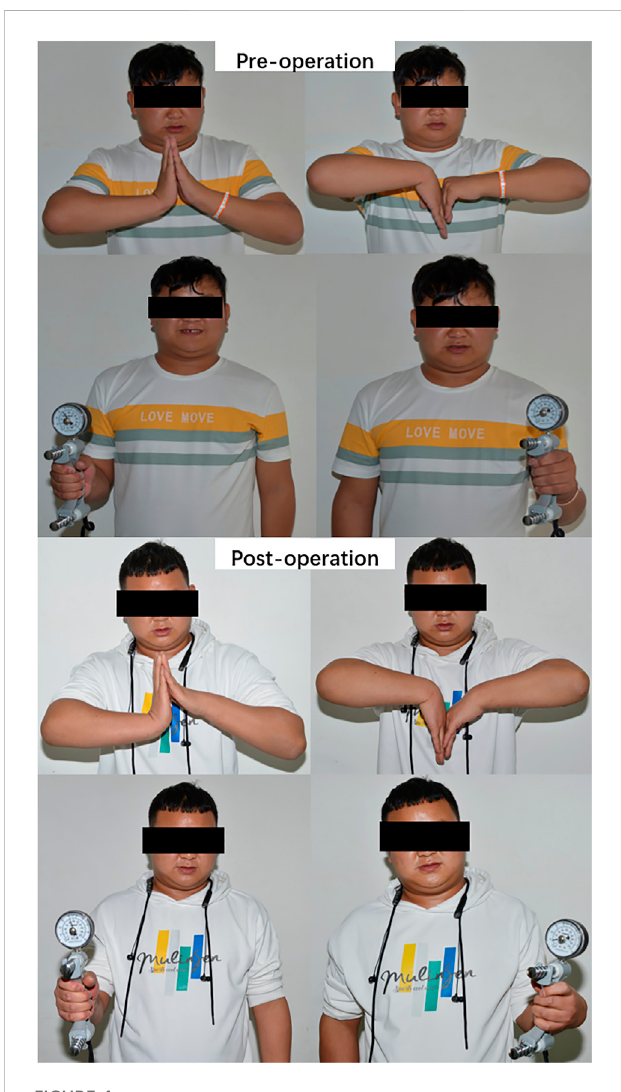
FIGURE 4 A patient with rheumatoid wrist arthritis with 24 months of follow- up after 3DMT-Wrist TWA.